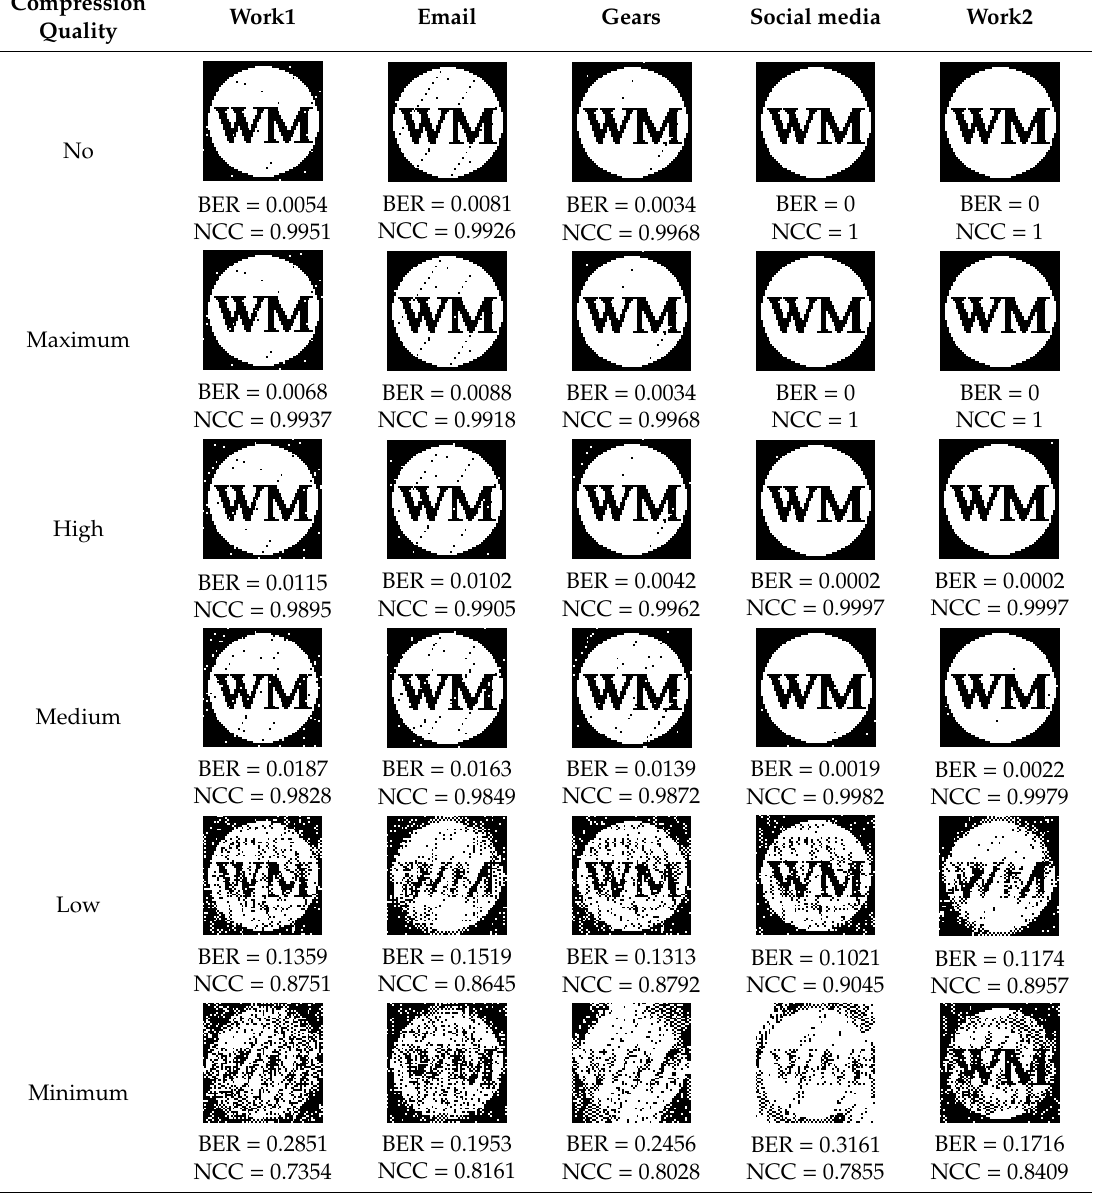
Table 3. Watermarks extracted from poorly detailed synthesized watermarked images obtained by the algorithm in [31].